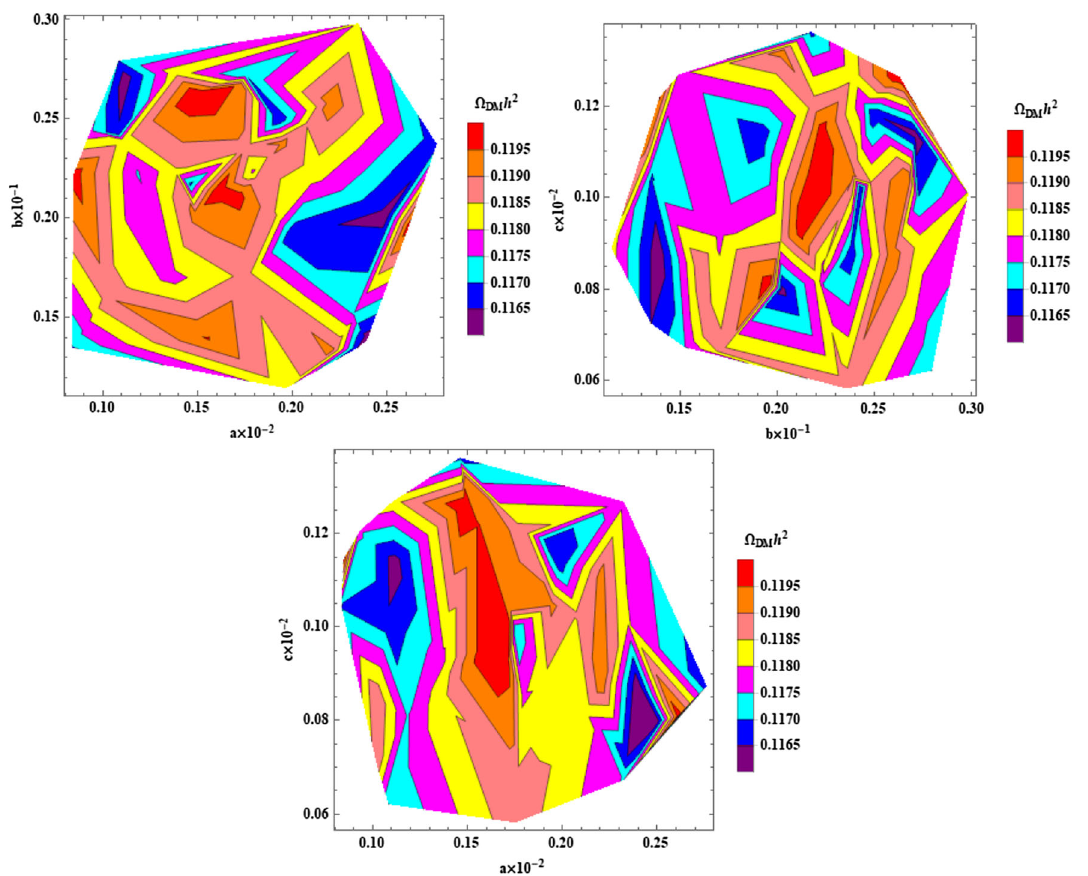
Fig. 13 Contour plot relating the model parameters a and b w.r.t the relic abundance ( (cid:20) DM h 2 ) of the DM candidate ( ξ ) (left panel), right panelshowsvariationofbandcwith (cid:20) DM h 2 andinthemiddleweshow